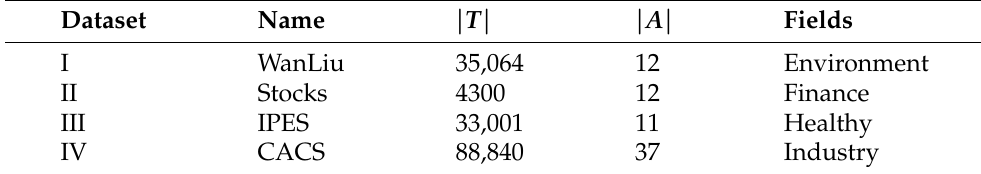
Table 6. The outlines of the